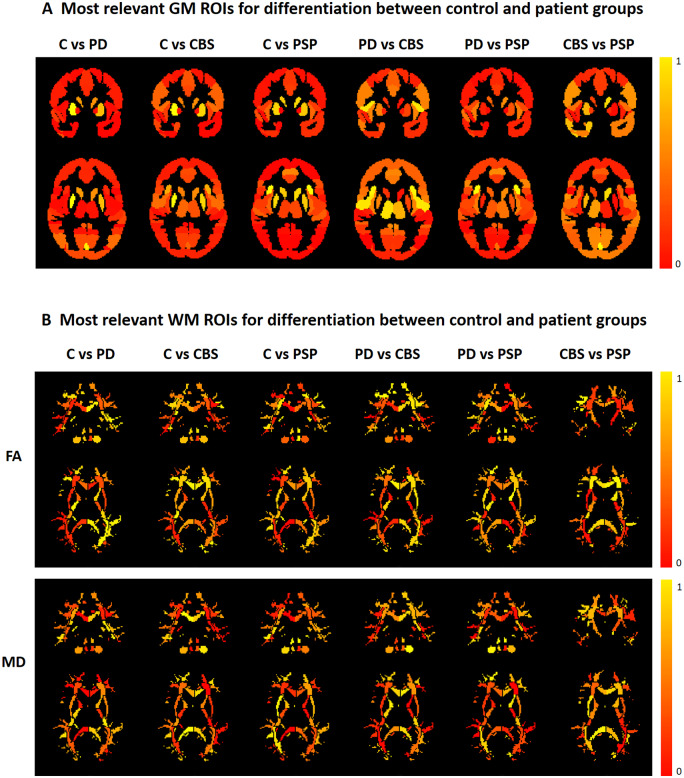

Spatial localization of top classification features. Colour-coded images showing the relative importance of each ROI for pairwise classification using SVM. The top ranked feature for each pairwise group comparison has a normalized weight of 1 and is shown in yellow, while the least important features are shown in red. (A) Cortical and sub-cortical ROIs used for classification with GM volume features. (B) White matter ROIs used for classification with FA and MD features. The top row shows the spatial distribution of the most relevant FA features, while the bottom row shows the localization of the most relevant MD features.